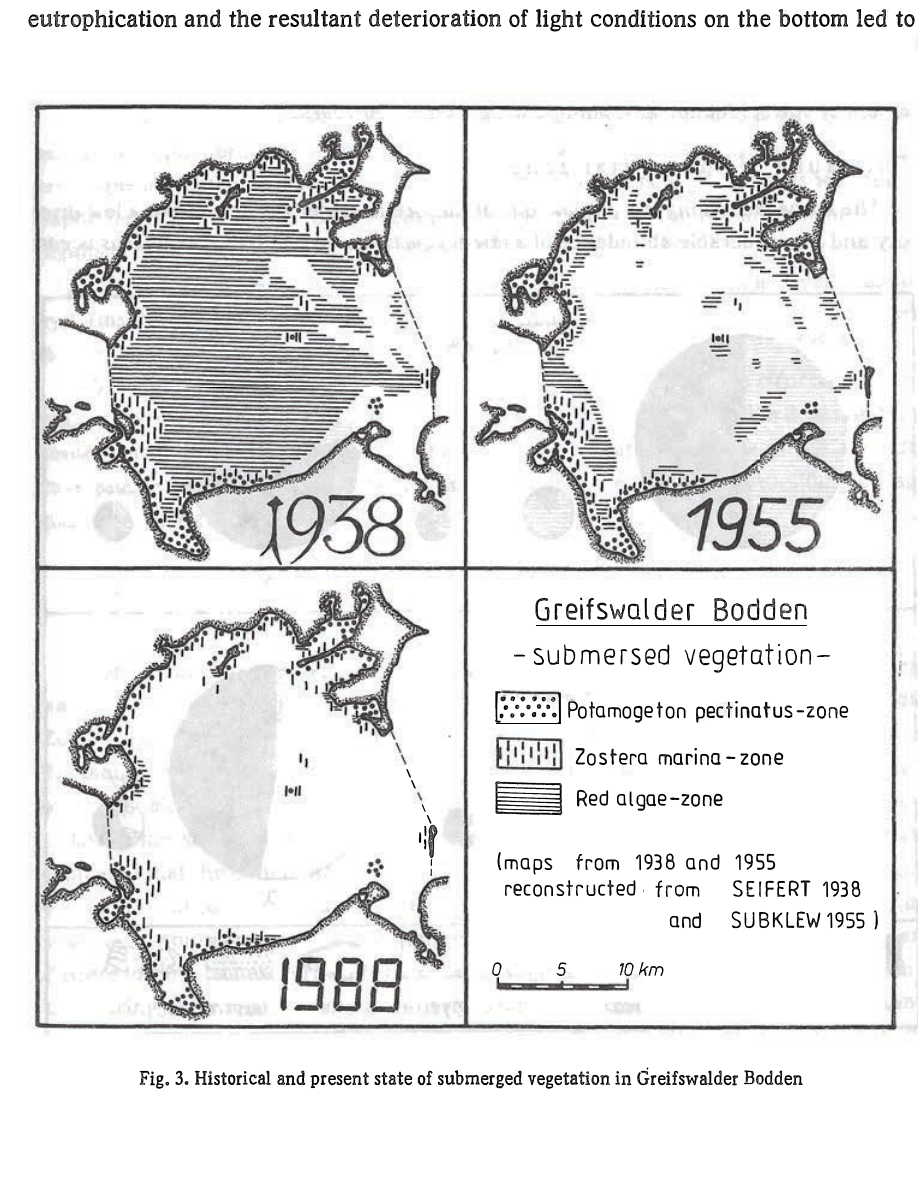
Fig. 3. Historical and present state of submerged vegetation in Greifswalder